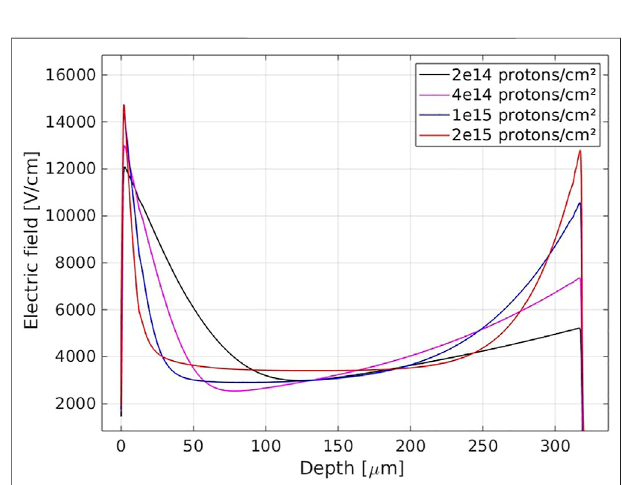
FIGURE 15 | Sentaurus TCAD – based simulation plot showing the variationintheelectric fi eldpro fi leacrosstheactivebulkofanirradiatedp-type silicon detector at different fl uences biased at 150 V, using the Eremin